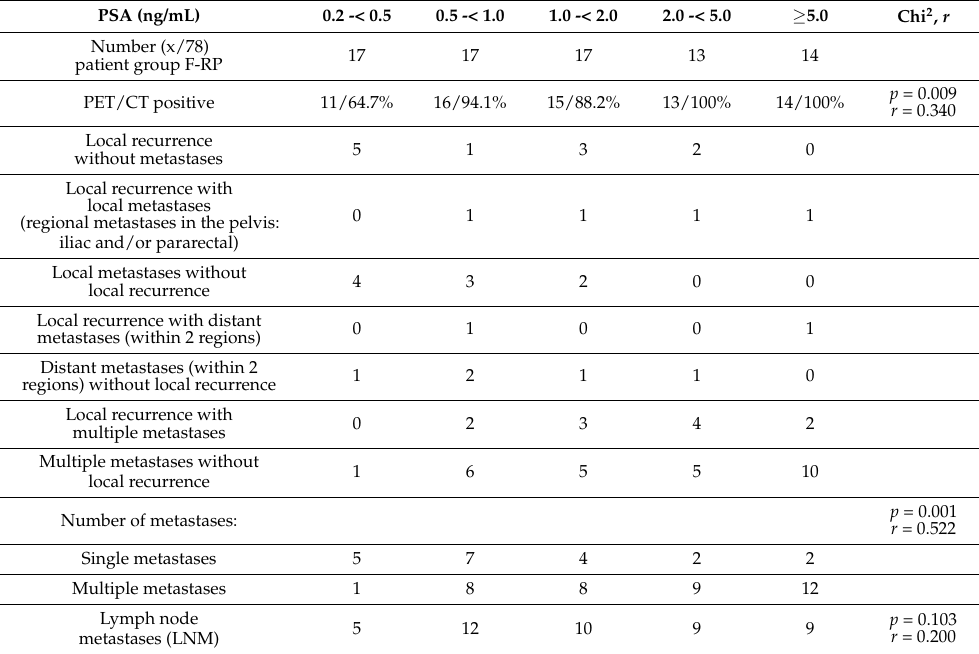
Table 5. Position of detectable cancerous lesions in [ 18 F]PSMA-1007 PET/CT patients (pretreated with radical prostatectomy/F-RP) with relation to